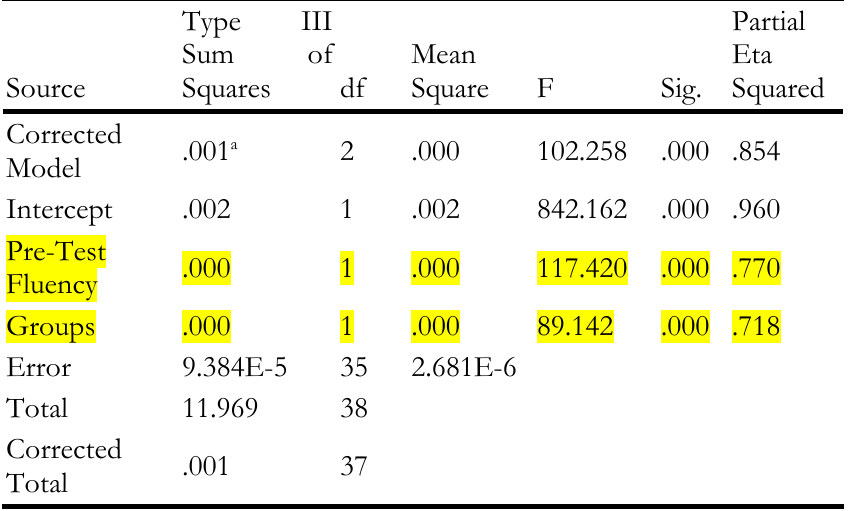
Table 2. Analysis of Covariance (ANCOVA) for Fluency